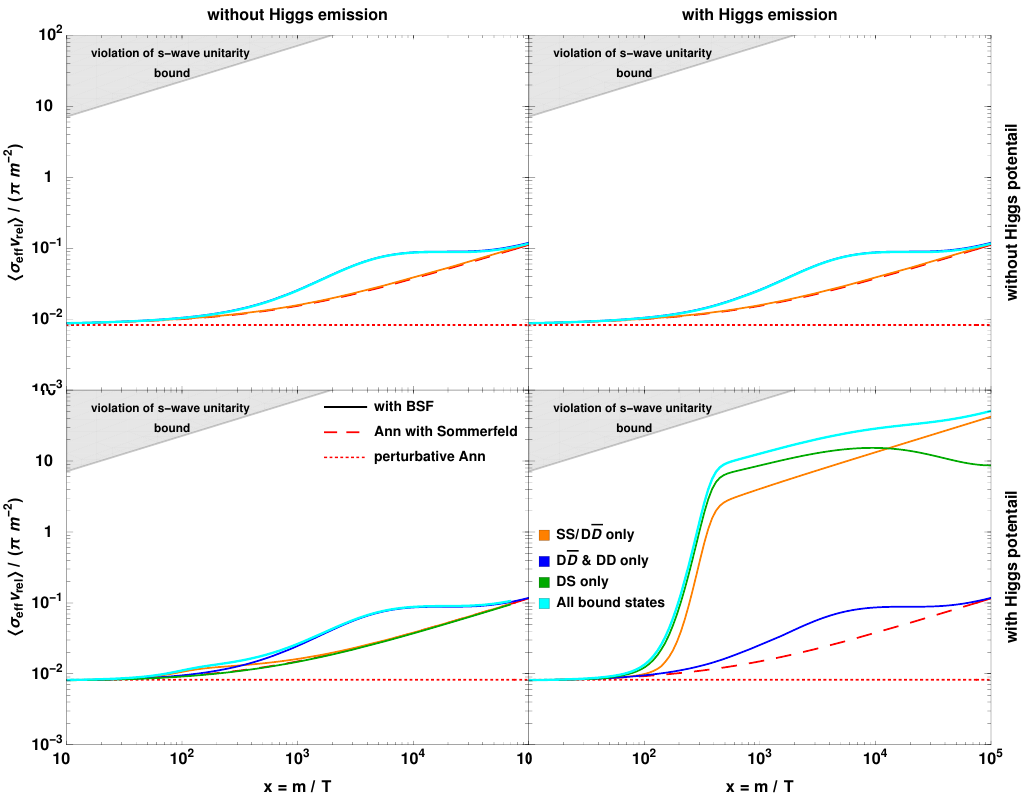
Figure 3 . Contributions to the effective DM destruction cross-section. The solid lines include direct annihilation with Sommerfeld effect plus BSF according to the colour legend. We have used m = 20 TeV , α H = 0 . 2 and the temperature dependent Higgs mass m H ( T ) . Note that the cross- sections have been regulated according to [35, section 3.6.]. The binding energy of the D ¯ D and DD bound states does not depend on the coupling to the Higgs, and their formation via H emission or exchange is always suppressed due the Higgs mass; their contribution is dominated by W emission. Both the SS/D ¯ D and DS binding energies depend on α , which ensures that their formation H via H emission is not suppressed when the Higgs-mediated potential is taken into account and provided that α is sufficiently large (bottom right panel.) The DS bound states do not exist H when neglecting the Higgs-mediated potential (upper